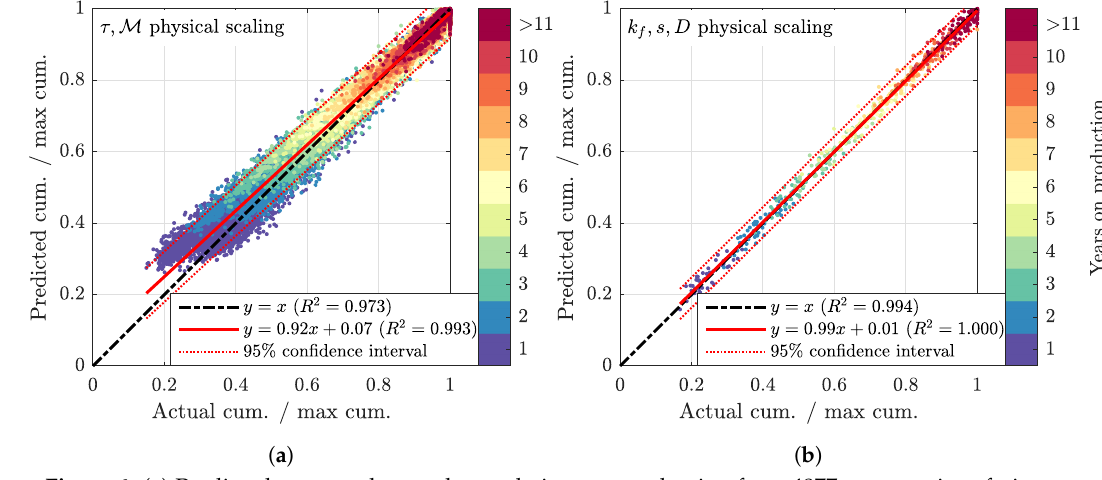
Figure 6. ( a ) Predicted vs. actual annual cumulative gas production from 4877 pressure-interfering wells in the Barnett play scaled with an extension of the method in [1]. There are 37,942 dots, i.e., on average 7.6 years on production are plotted for each well (see the caption of Figure 2). The least squares fit of this cross-plot has some bias and offset (predicted = 0.92actual + 0.07), which is not surprising for such a large heterogeneous set of wells. ( b ) The multiscale (“ k f , s , D ”) well performance model proposed in this paper. We plot the predicted cumulative gas production in one year increments vs. the one measured in 45 horizontal wells in the Barnett, each with 13.3 years on production on average, and each pressure-interfering. There are 597 dots of 11 colors. Time is progressing along the diagonal away from the origin. The least squares fit of this cross-plot has no bias and offset (predicted = 0.99actual + 0.01). The 95% CI that this fit explains the linear trend in data is so tight we do not plot it. The 95% CI that a new well will belong to this dataset is plotted as the two red dotted lines. A mixture of simple scaling models published elsewhere and this paper’s multiscale model can provide crucial economic insights about well